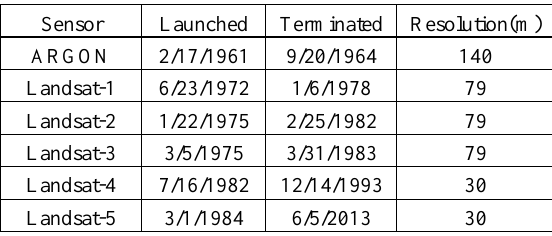
Figure 2. Example of manually seeds points selection and measurement. (a) and (b) are correspondences in crevasses from 1975 and 1988, (c) and (d) are correspondences in ice-shelf front from 1988 and 1989, (e) and (f) are correspondences in longitudinal linear surface structures from 1973 and 1975.